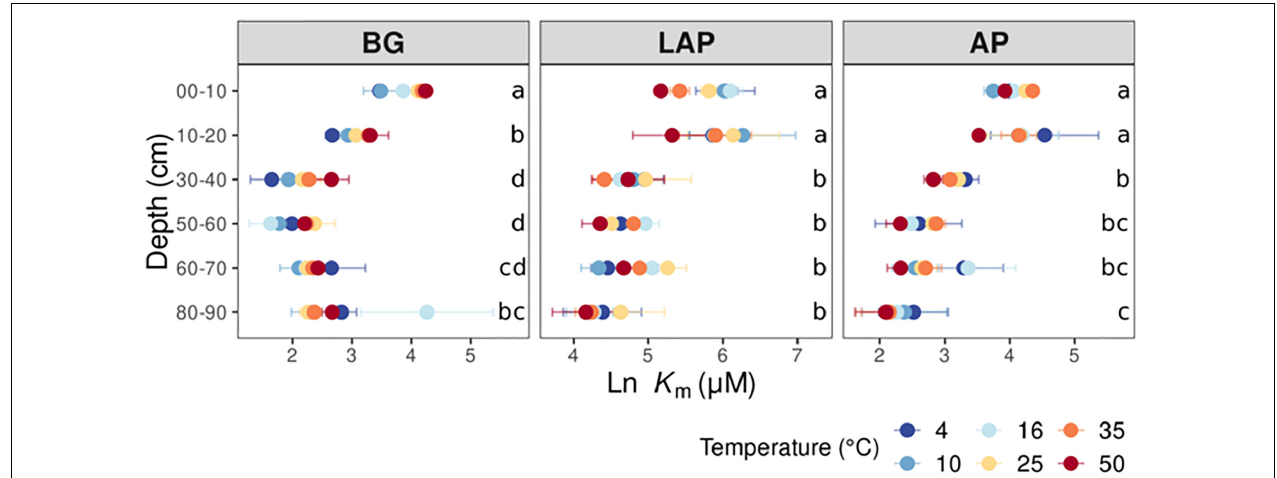
FIGURE 2 | Enzyme Michaelis constant ( K m ) at different depths and six temperatures from 4 to 50 ◦ C. Two-way ANOVA with depth and temperature as interactive factors indicated that depth had a significant effect on K m of all enzymes ( p < 0.05), whereas temperature only had a significant effect on K m of BG ( Table 3 ). There was no depth × temperature effect. Colors indicate incubation temperatures and letters indicate significant differences ( p < 0.05) between depths per enzyme, based on Tukey’s tests after ANOVA tests. Error bars represent the standard error of the mean ( n =